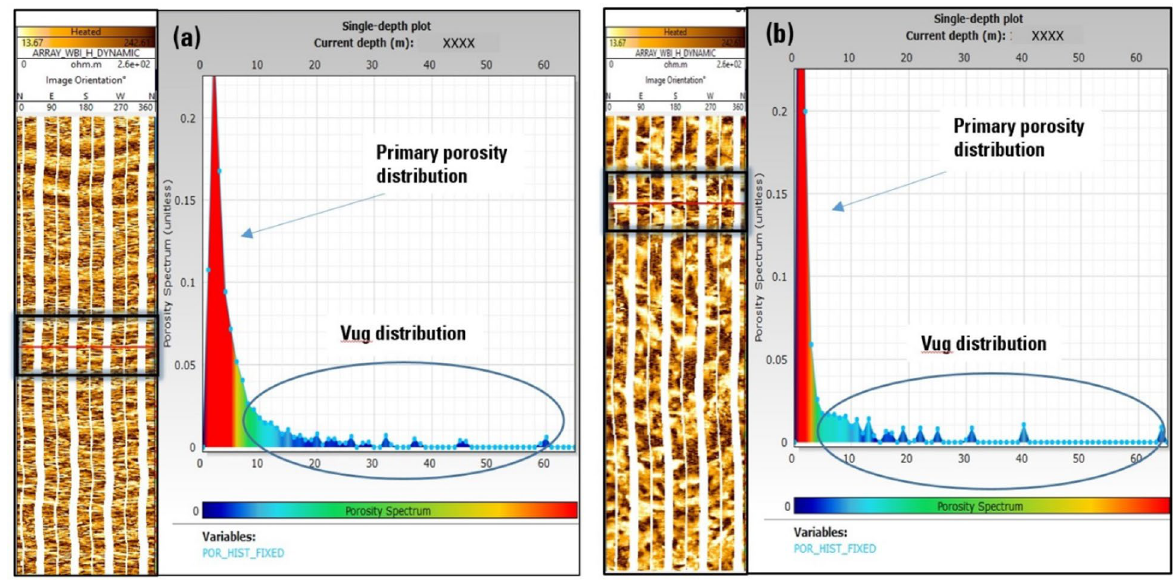
Fig. 3 Distribution of porosity type. Shows mostly secondary type of porosity in a U. Shuaiba Formation and b L. Shuaiba Formation in well